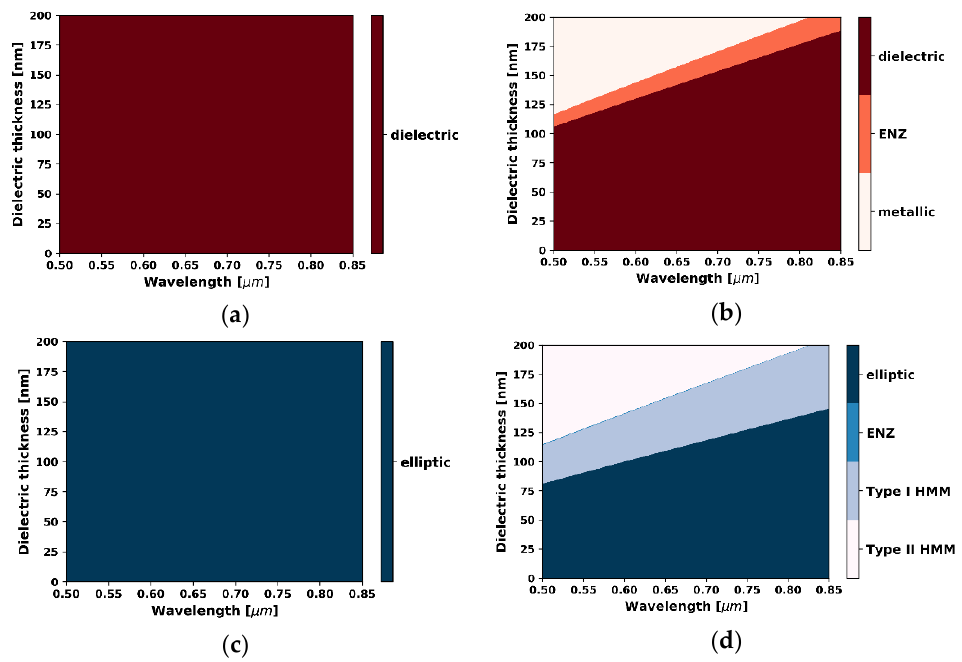
Figure 2. Maps of effective dispersion types of the HMM medium described with local ( a , c ) and nonlocal EMT ( b , d ) plotted as a function of wavelength and dielectric layer thickness for TE- ( a , b ) and TM-polarized waves ( c , d ) and for 𝑘⃗ = [𝑘 𝑥 , 𝑘 𝑦 , 𝑘 𝑧 ] = [0, 0, 𝑘 0 ] .